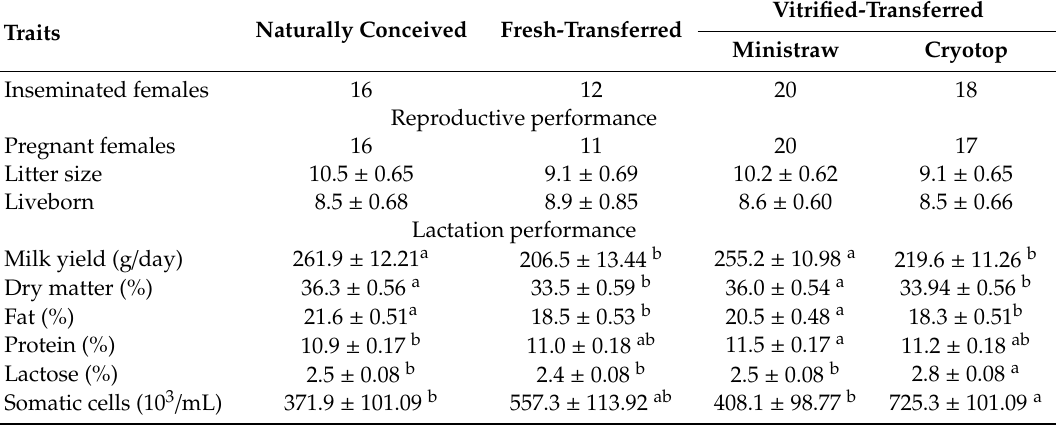
Table 3. Female reproductive and lactation performance: comparing di ff erences between naturally conceived females and those born after fresh embryo transfer, vitrified embryo transfer using ministraw, and vitrified embryo transfer using